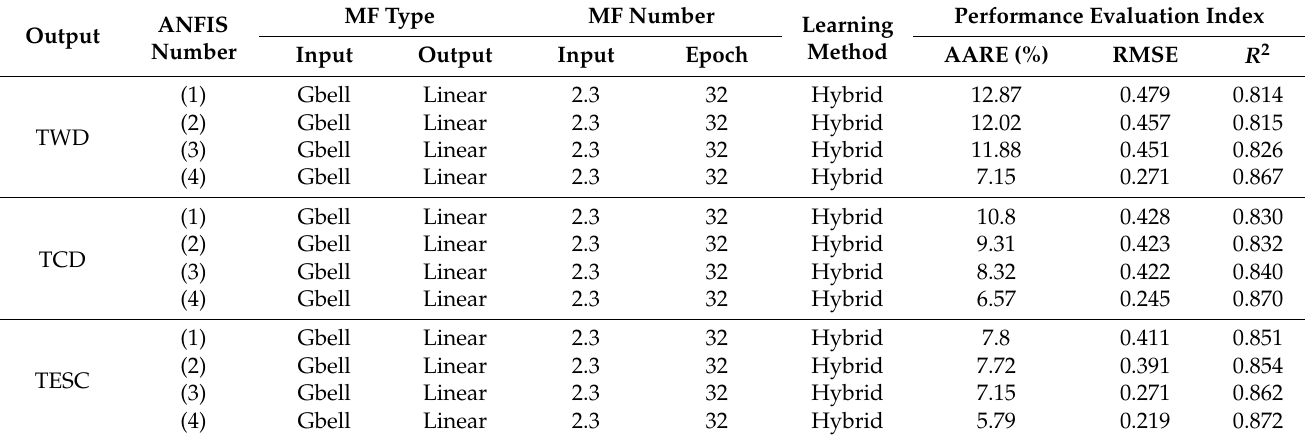
Table 8. Characteristics of two-level ANFIS model with the best structure for mushroom production.